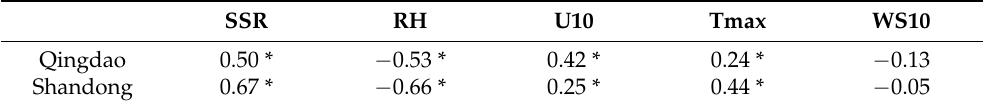
Table 2. Correlation coefficients between MDA8 ozone concentrations and possible meteorological factors over land from the ERA5 dataset during summer 2014–2019. SSR RH U10 Tmax WS10 Qingdao 0.50 * − 0.53 * 0.42 * 0.24 * − 0.13 Shandong 0.67 * − 0.66 * 0.25 * 0.44 * −